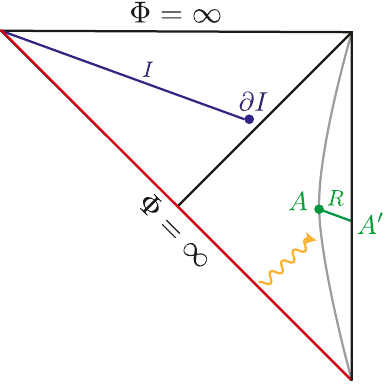
Figure 7 . Using the formula for the fine-grained entropy, we compute the entropy S ( R ) of the region R = [ A, A 0 ] defined by the gray anchor curve which contains radiation emanating from the past horizon. Gravity is weak in the region R . Because the radiation is entangled with the region beyond the future horizon, we allow for the possibility that an island I contributes to S ( R )